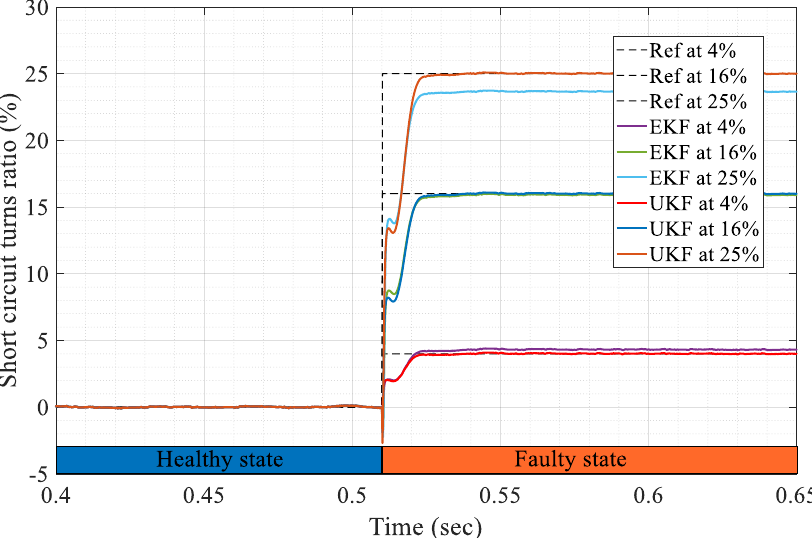
Figure 9. EKF estimation response in phase A at a load of 0.72 A and a frequency of 30 Hz.